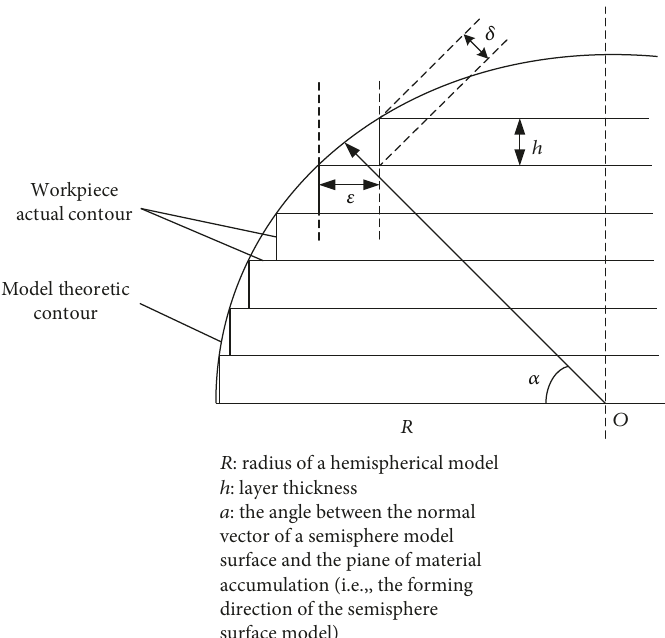
Figure 6: The local schematic of the “ Step E ff ect ” for forming